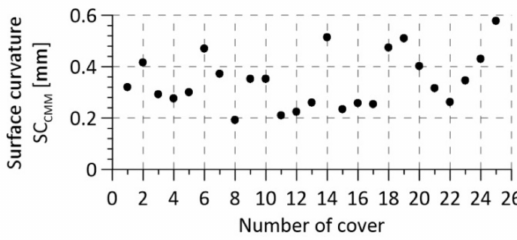
Figure 9. Curvature of the reference surface of the